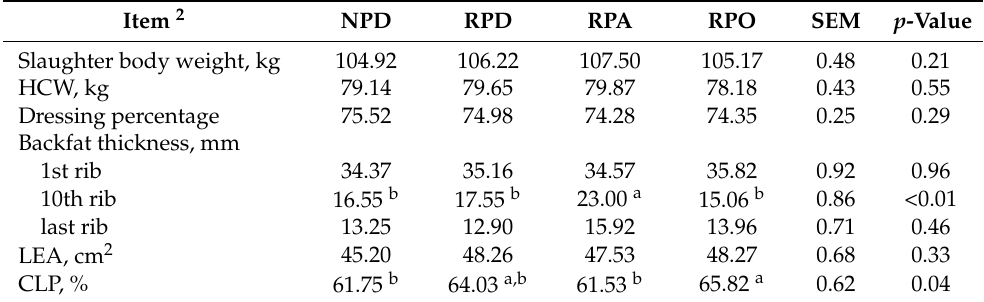
Table 4. Influences of inclusion of oregano essential oil in a low-protein diet on carcass traits of growing-finishing pigs 1 .